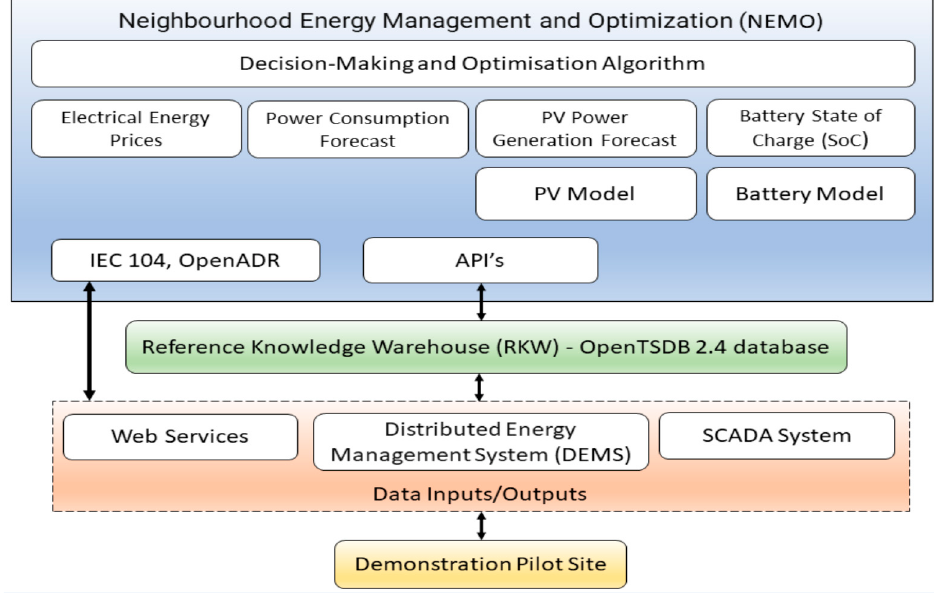
Figure 5. The NEMO Architecture and interfaces. The decision-making and optimisation algorithm requires the energy prices, power consumption, PV generation and battery SoC from the RKW. The RKW collects the operational data of the swimming pool using SCADA, the consumption forecast from DEMS and the electricity prices from the web.